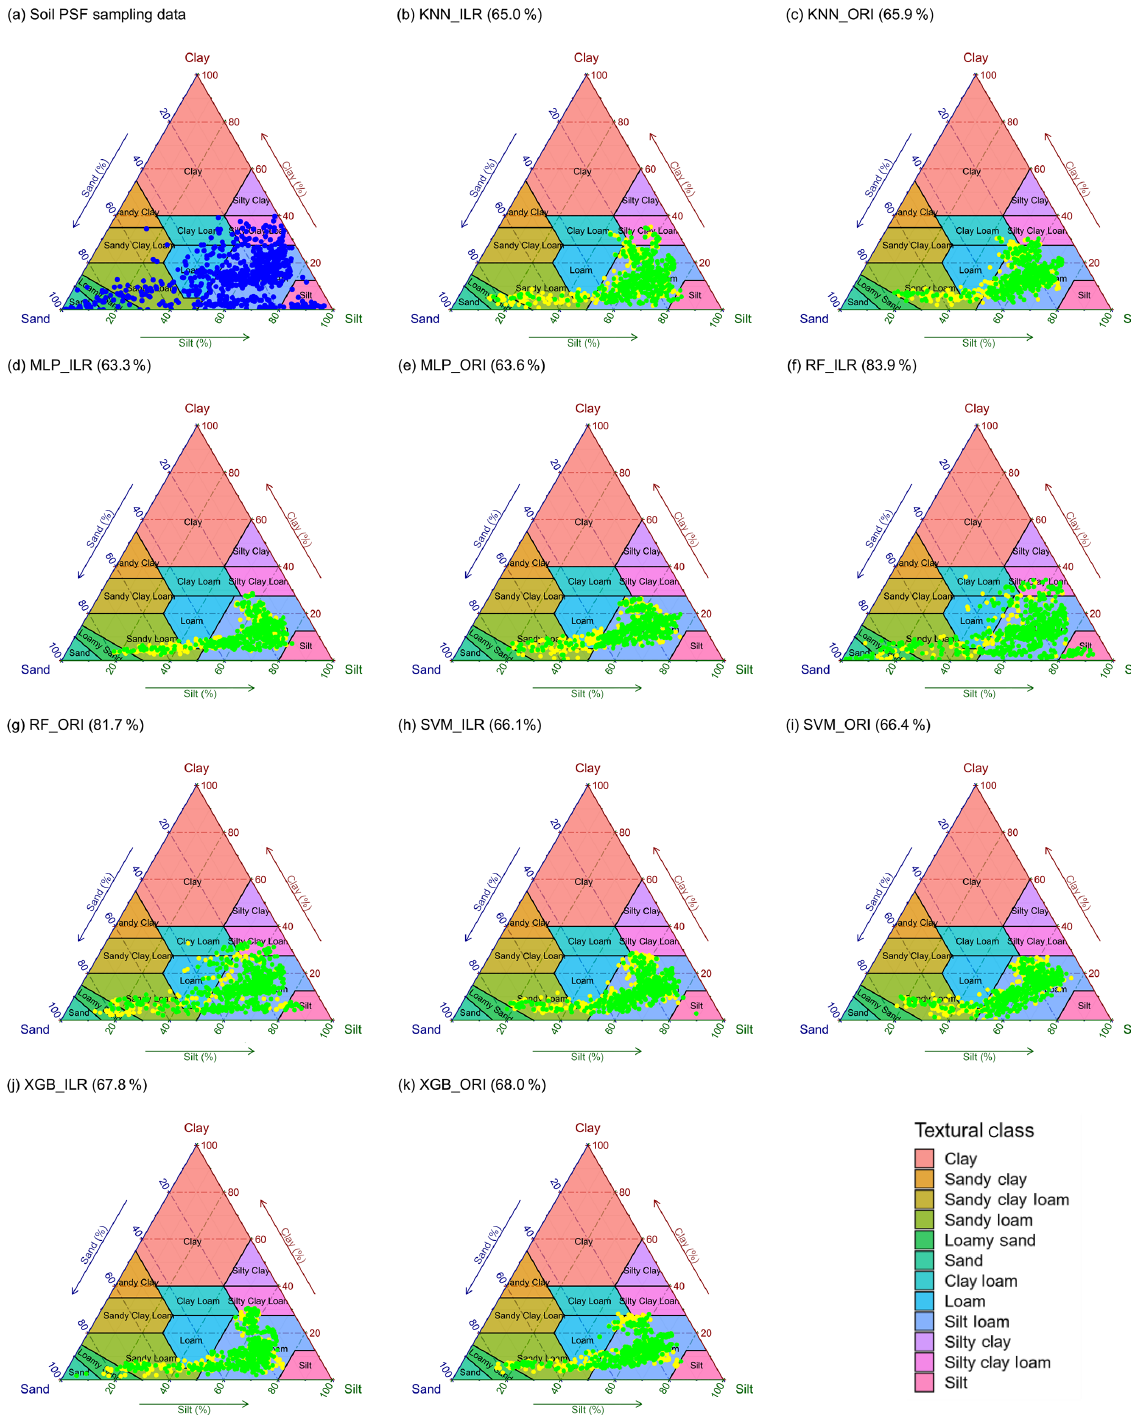
Figure 8. Soil texture types of 640 soil samples shown using the USDA texture triangle. The results of soil PSFs were generated from (a) soil PSF samples, (b) KNN_ILR, (c) KNN_ORI, (d) MLP_ILR, (e) MLP_ORI, (f) RF_ILR, (g) RF_ORI, (h) SVM_ILR, (i) SVM_ORI, (j) XGB_ILR, and (k) XGB_ORI. Note that the green symbols represent that the predicted and original soil texture classes were the same, whereas the yellow symbols represent the misclassification of the soil texture classes. The predicted right ratios (RRs) of the soil texture classes are given in parentheses after the interpolators above the